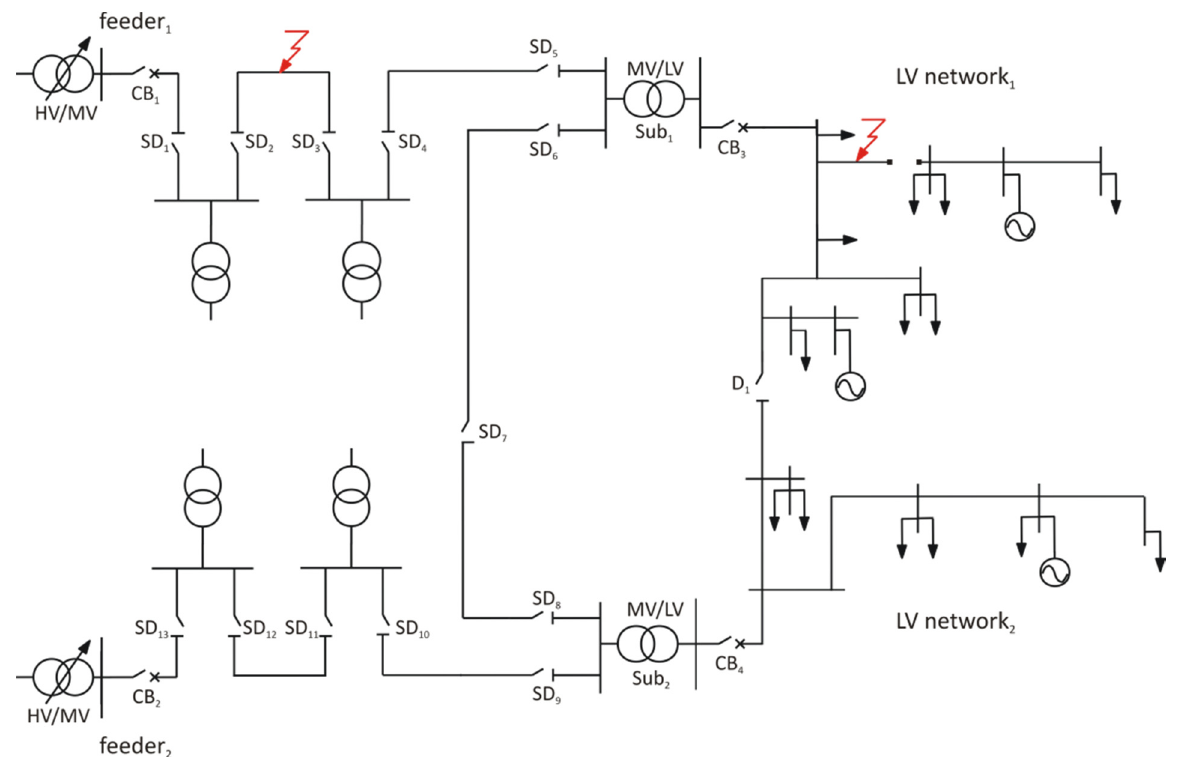
Figure 1. Simple distribution system with